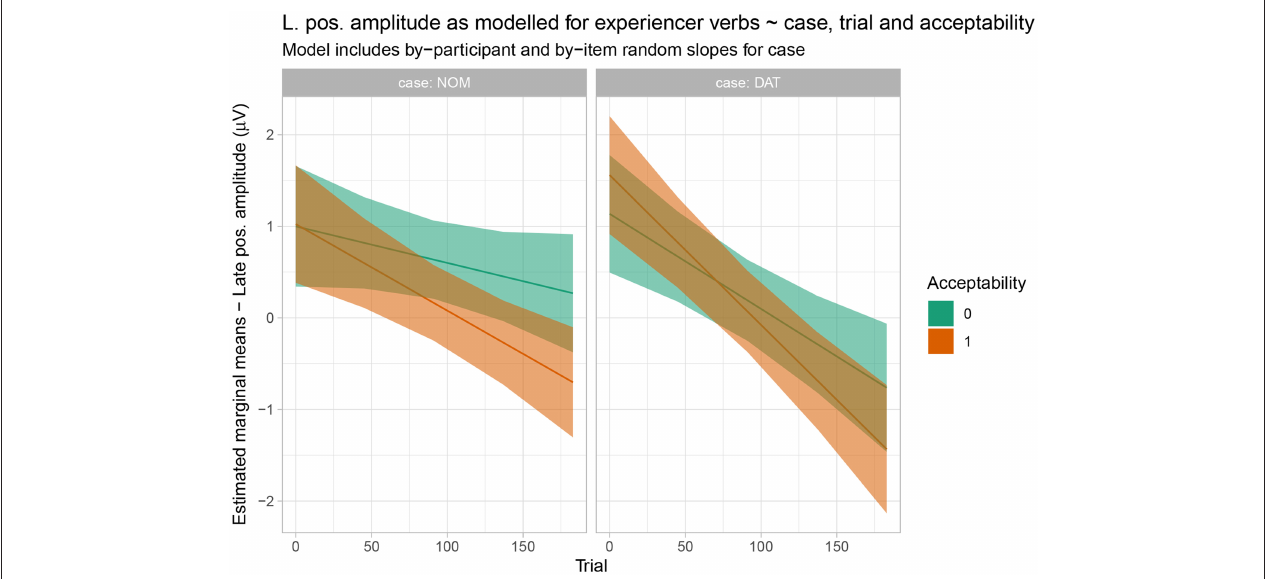
FIGURE 9 | Estimated marginal means for the response-contingent analysis of the experiencer verb data in the late positivity time window. Shaded regions indicate 83% confidence